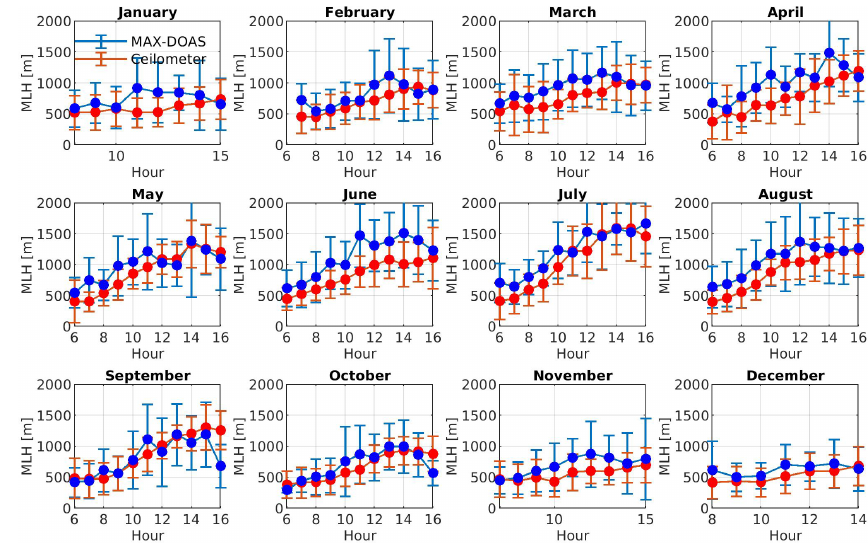
Figure 3. Comparison of monthly averaged MLH diurnal variations as estimated by the BIRA-IASB MAX-DOAS measurements and the colocated ceilometer. The error bars for both datasets represent the standard deviation ( ± 1 σ ) of the hourly mean over 1 month.